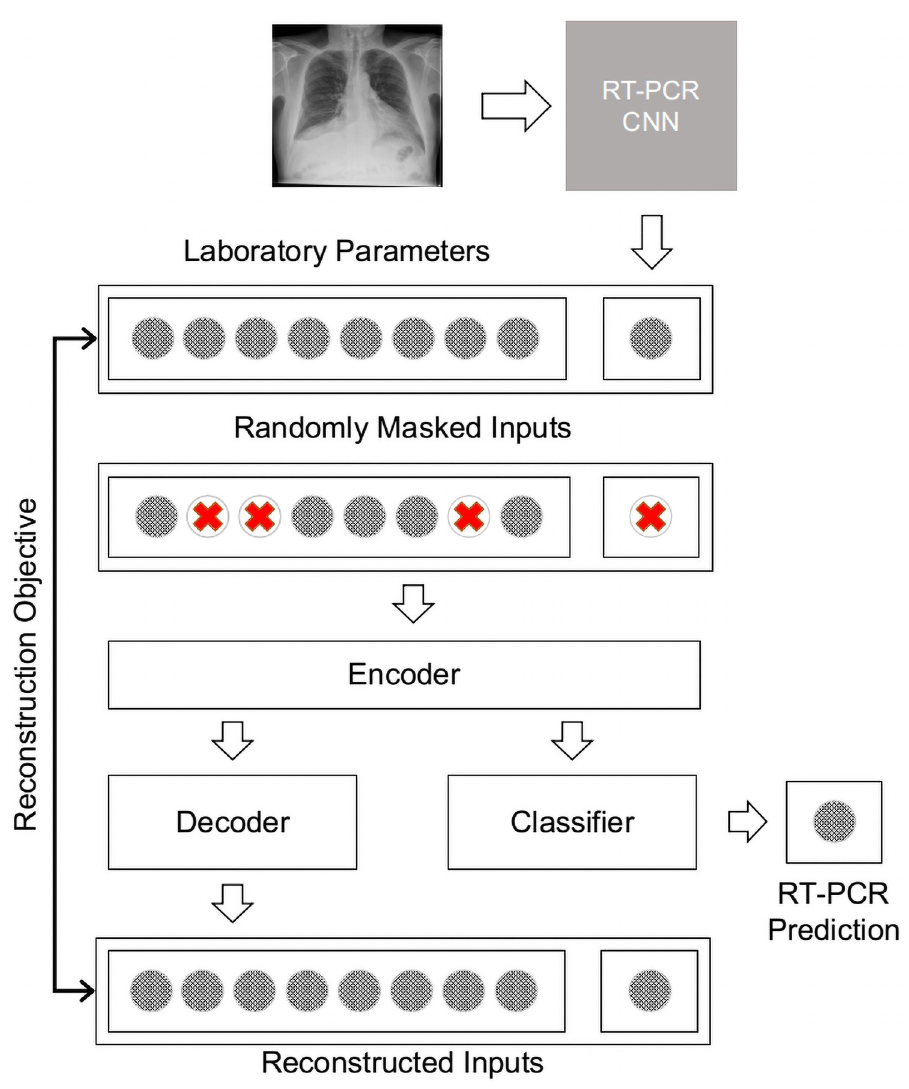
Fig 2. High level illustration of the architecture underlying the neural networks in the ablation study. The RT-PCR classifier score from the chest x-ray is extracted using a CNN (top-right). This score is concatenated with the laboratory parameters. During training, inputs are masked by removing a certain percentage of the inputs randomly. The models incorporate an encoder, a classifier (for RT-PCR result prediction), and a decoder to reconstruct the masked